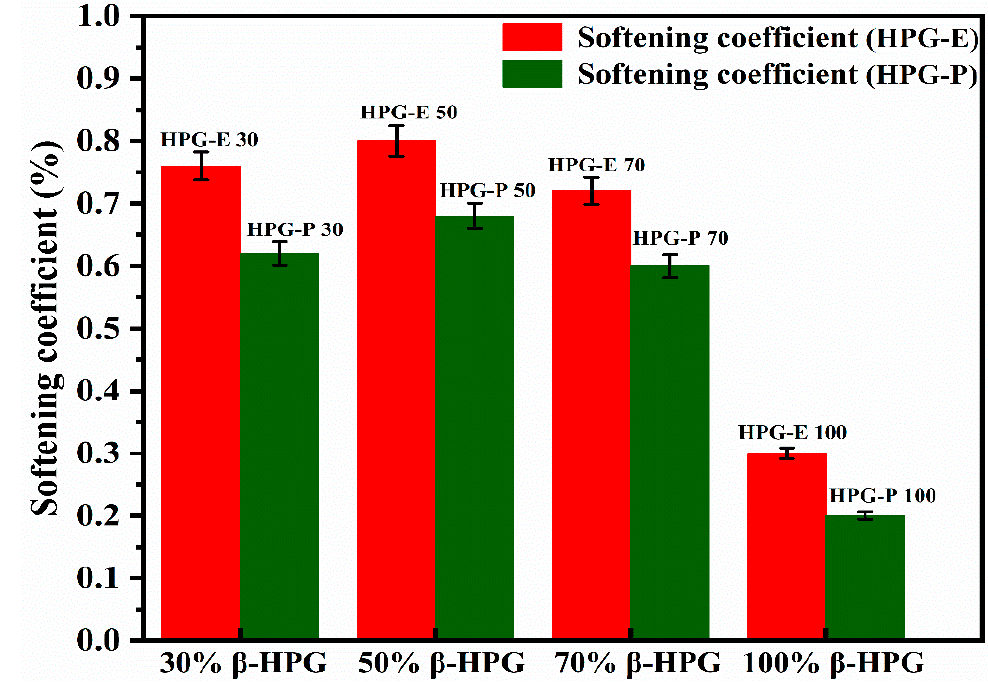
Figure 8. Softening coefficients of the as-prepared specimens.